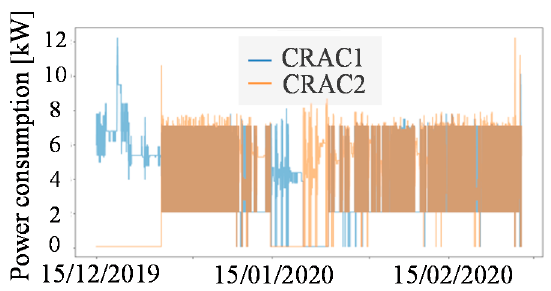
Figure 4. Setting of return temperature.